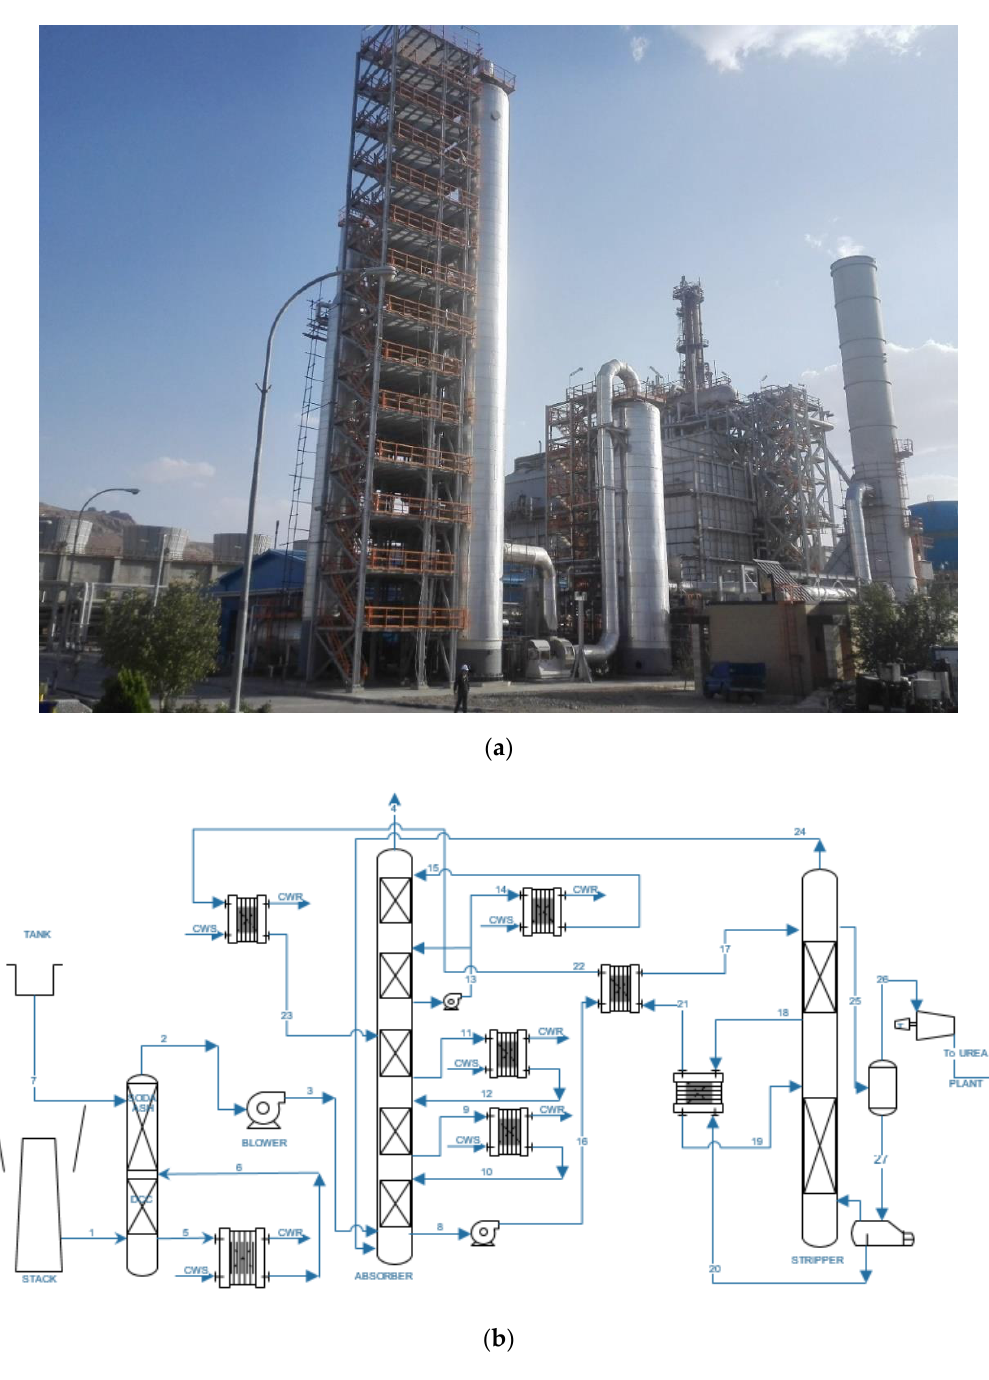
Figure 2. ( a ) The industrial CCU plant. ( b ) Schematic of the plant based on the process flow diagram. Table 2. Composition of the flue gas